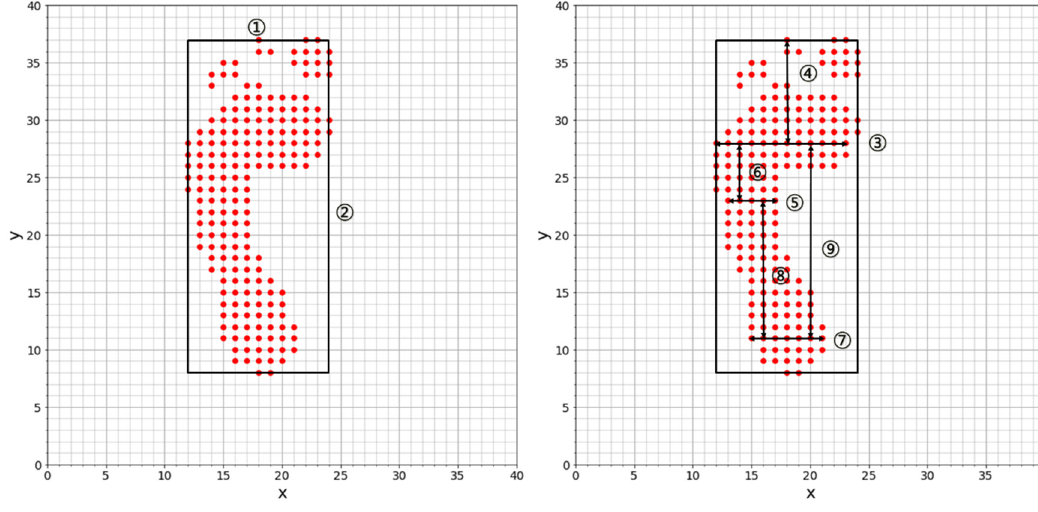
Figure 13. Nine features derived from foot pressure.